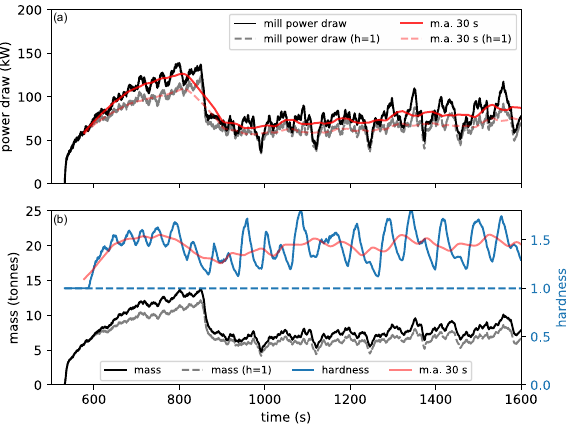
Figure 9. The response in the mill power draw ( a ) from a step change in the ore hardness ( b ) after passing through the storage in Figure 6. The ore mass in the mill is also included and a 30 s moving average of the power draw and hardness. For reference, the case of constant hardness ( h = 1) is also included.